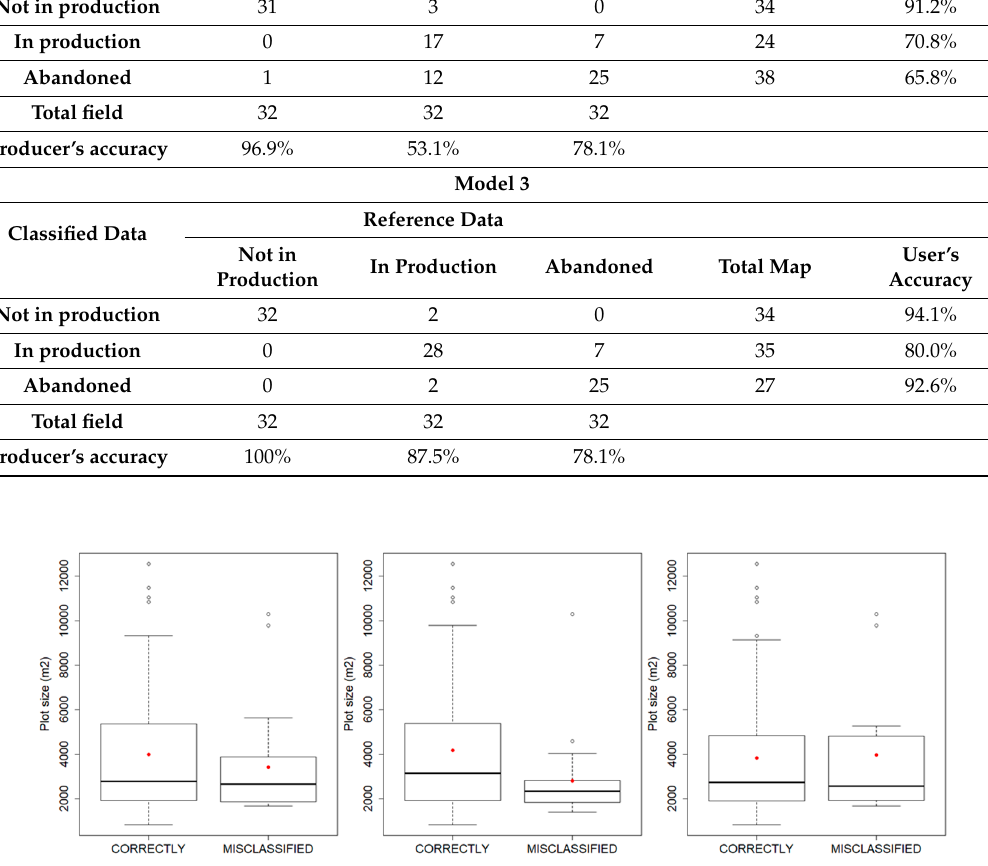
(c) Figure 9. Importance of the variables according to Mean Decrease in Gini. Importance of Model 1 variables ( a ), Model 2 ( b ) and Model 3 ( c ). 4. Discussion Our results showed that high-resolution airborne images with four spectral bands generate more accurate results than Sentinel-2 images for mapping abandoned citrus plots. High-resolution images were the best alternative for the study of abandonment at the cadastral plot level. However, processing these images is more costly from a computational point of view than processing Sentinel- 2 images. Adding 20 m Sentinel-2 bands did not improve the accuracy of the classification, despite havingmore spectral information. The NDMI calculated from the 20 m bands of Sentinel-2 was not able to improve the classification accuracy. This is because the spatial resolution of these bands is not